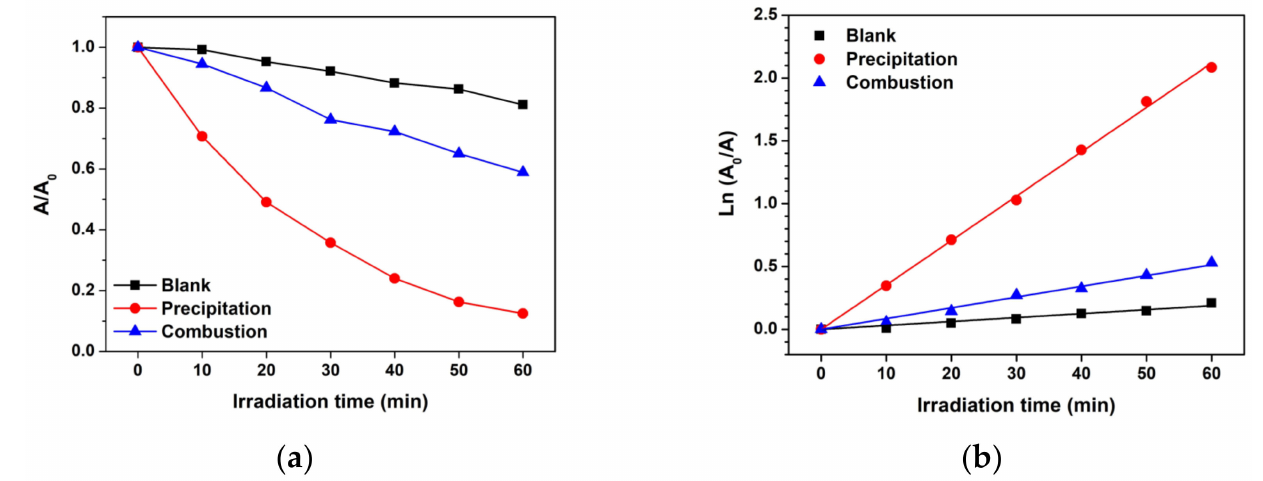
Figure 11. Photocatalytic performance of MB degradation under natural sunlight: ( a ) plot of A/A 0 analysis and ( b ) apparent degradation rate constant